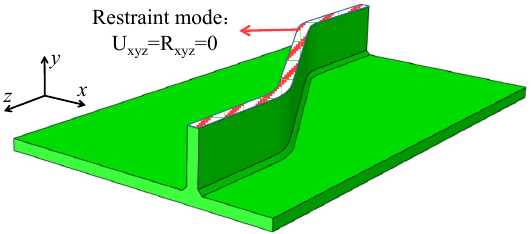
Figure 5. Meshing and boundary conditions model of CSWs. ( a ) Corrugated angle 30°; ( b ) Corru- gated angle 45°; ( c ) Corrugated angle 60°.